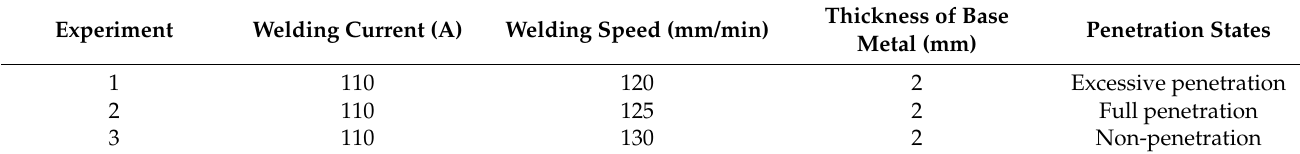
Table 1. Welding parameters in three penetration